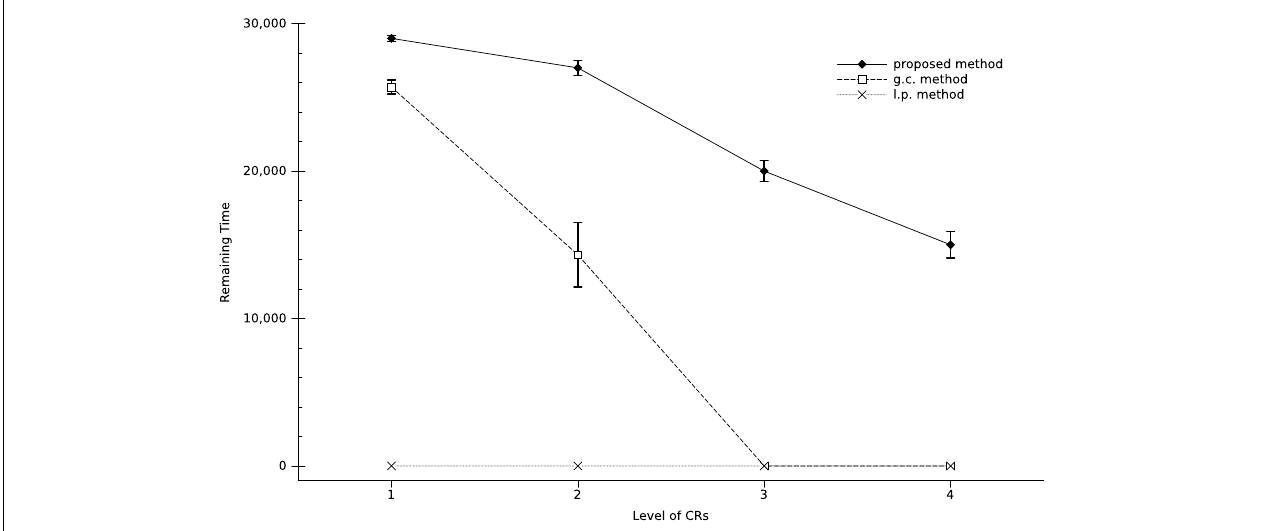
FIGURE 4 | Required time steps for the acquisition of skills in each method . The proposed method is four to eight times faster than the g.c.